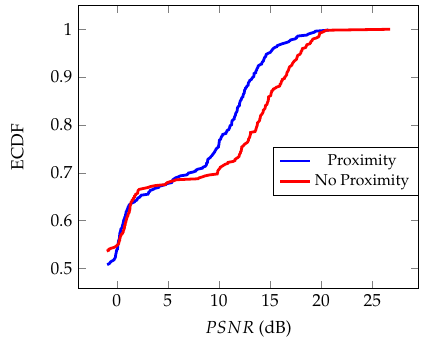
Figure 10. Empirical Cumulative Distribution Function of PSNR, Equation (12), for K-SVD denoised simulated interferogram with and without